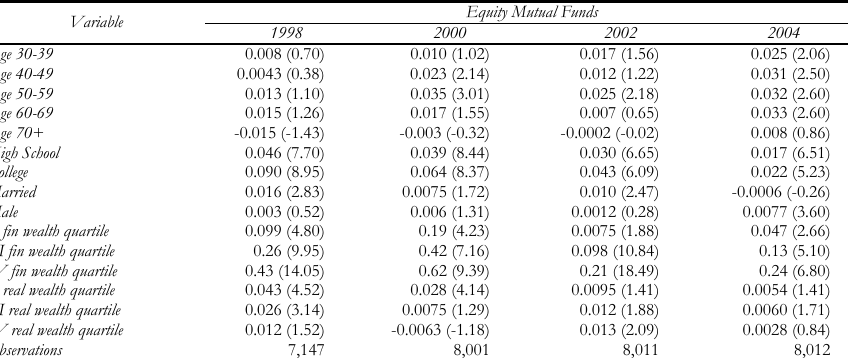
Cross-sectional Probit Regressions for Indirect Stockholding The coefficients in the table indicate the marginal effect of the regressor on the probability to invest in equity mutual funds. Each of the regressors is a dummy variable. z-statistics are reported in